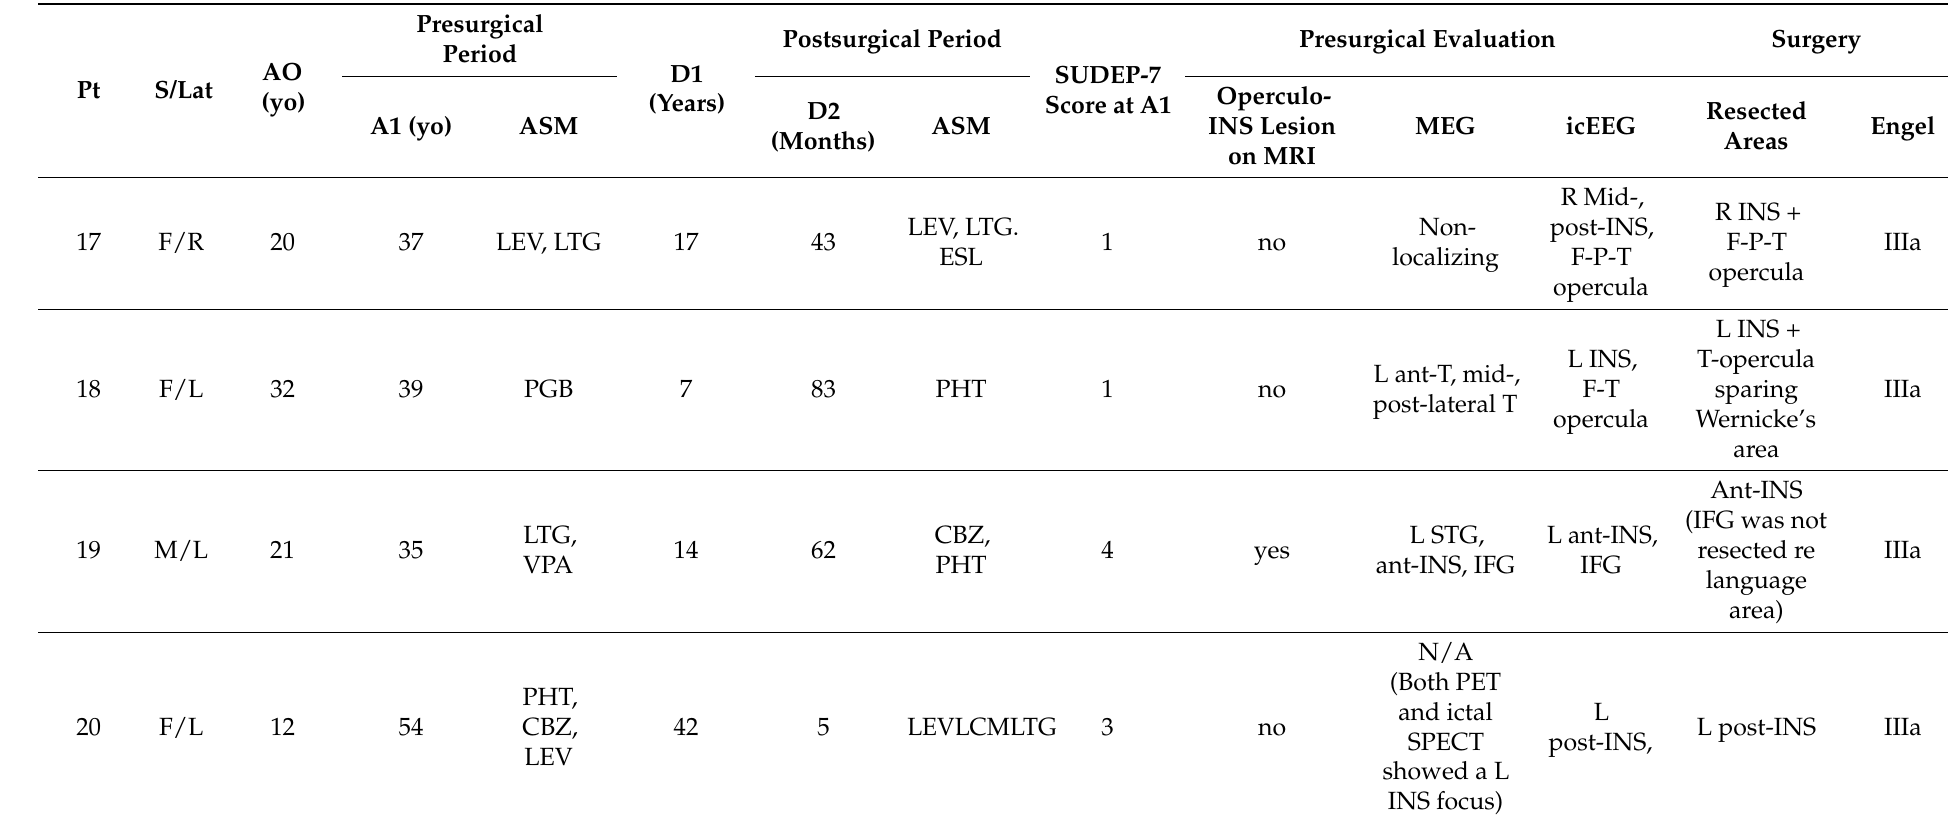
Table A4. Summary of presurgical, surgical and postsurgical data of four probable IOE